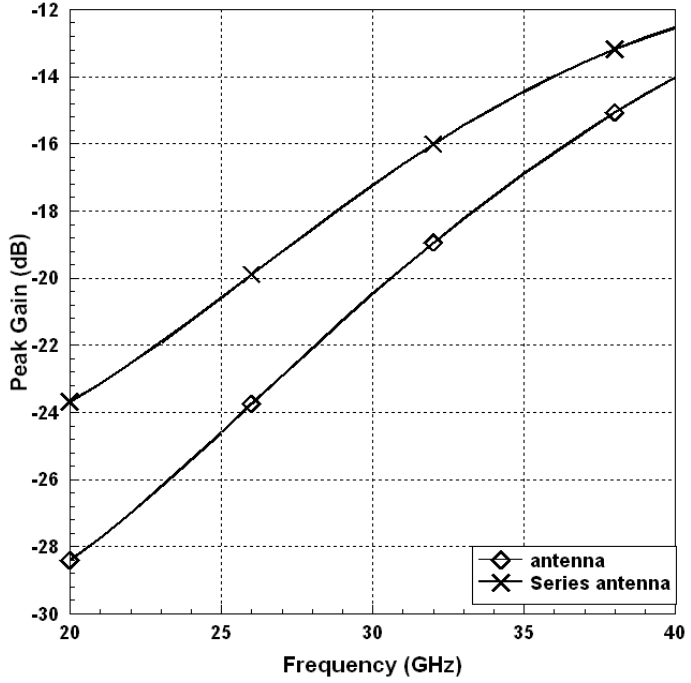
Figure 7. Comparison of the gain of the chip antenna stacked structure with the unstacked one.